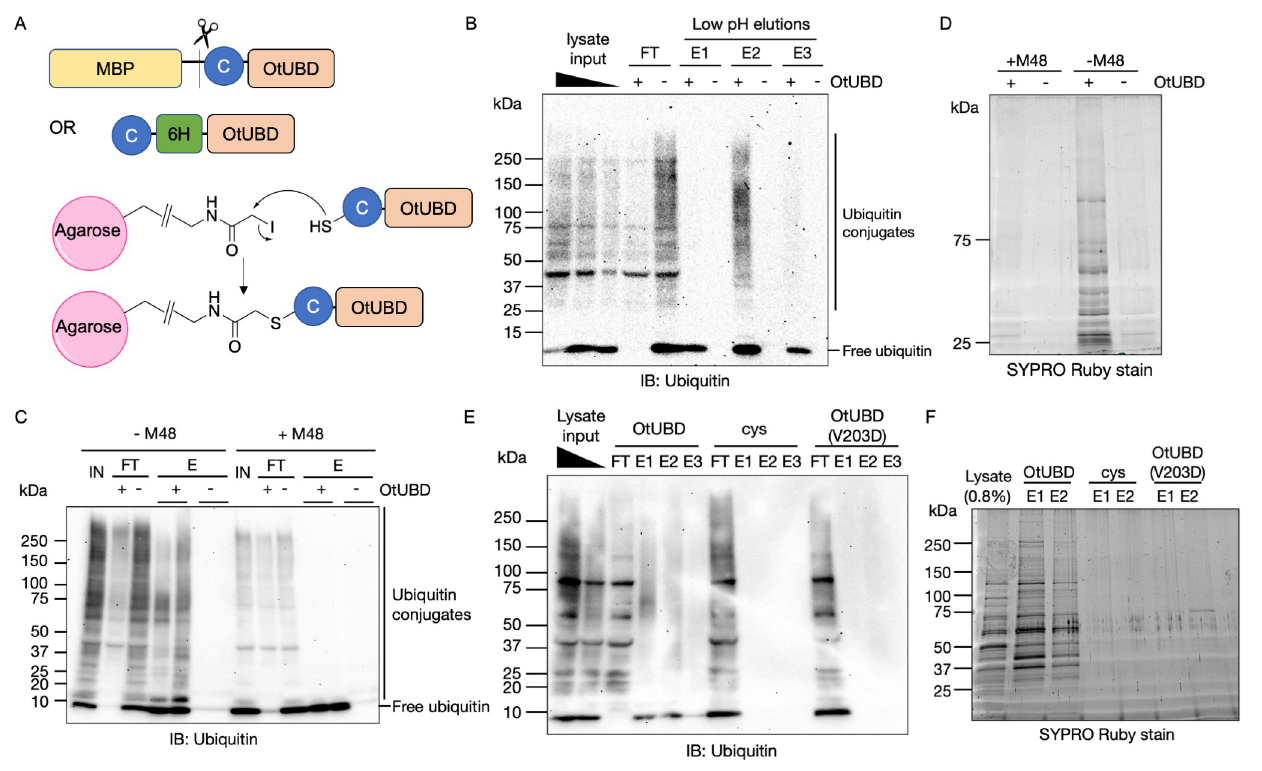
Fig 2. A covalently linked OtUBD resin purifies ubiquitin and ubiquitylated proteins from yeast lysates. (A) OtUBD constructs used for covalent coupling to resin and mechanism of the coupling reaction. An engineered cysteine at the amino terminus of OtUBD enables its covalent conjugation to the SulfoLink resin. (B) Ubiquitin blot of pulldowns from yeast cell lysate using covalently linked OtUBD resin or control resin. Covalently linked OtUBD resin efficiently pull down ubiquitylated species from yeast whole cell lysate. FT, flow-through; E1/E2/E3, eluted fractions using a series of stepwise, low pH elutions. (C, D) Extract pretreatment with M48 DUB cleaves ubiquitin from ubiquitylated species and greatly reduces the total protein pulled down by OtUBD resin. (C) Anti- ubiquitin blot of OtUBD pulldown of yeast lysate with or without M48 DUB treatment. (D) Total protein present in the eluted fractions of the OtUBD pulldowns visualized with SYPRO Ruby stain. (C and D are from 2 separate biological replicates.) IN, input; FT, flow-through; E, eluted fractions. (E, F) The V203D mutation in OtUBD, which greatly impairs its binding of ubiquitin, prevents enrichment for ubiquitylated species from yeast lysate. (E) Anti-ubiquitin blot of pulldowns of yeast lysates using OtUBD resin, Cys resin (negative control), and OtUBD(V203D) resin. (F) Total protein present in the eluted fractions of the OtUBD pulldowns visualized with SYPRO Ruby stain. IN, input; FT, flow-through; E1/2/3, eluted fractions using a series of low pH elutions. MBP, maltose-binding